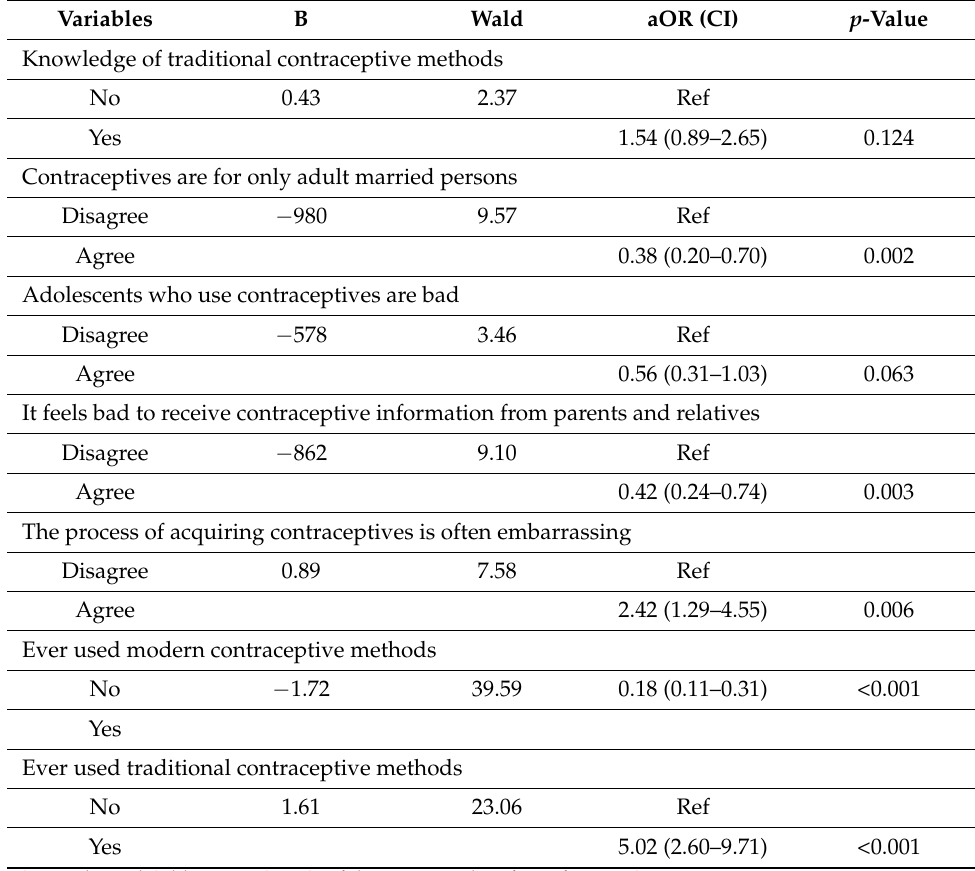
Table 3. Adjusted Association between Adolescents’ Knowledge, Attitudes, and Use of Contracep- tives on